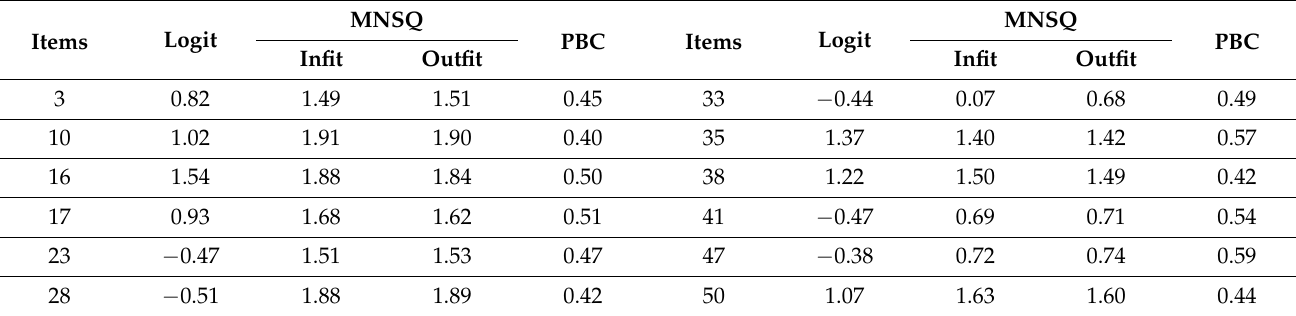
Table 9. Results of Item Relevance Verification.